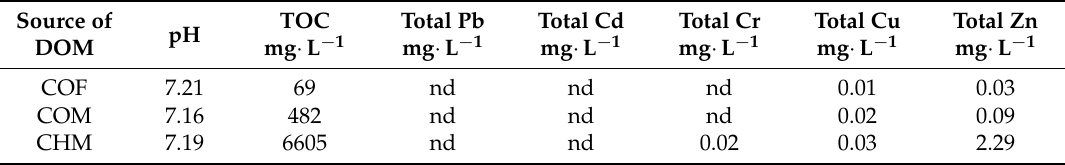
Table 1. Physicochemical properties of dissolved organic matter (DOM) from different